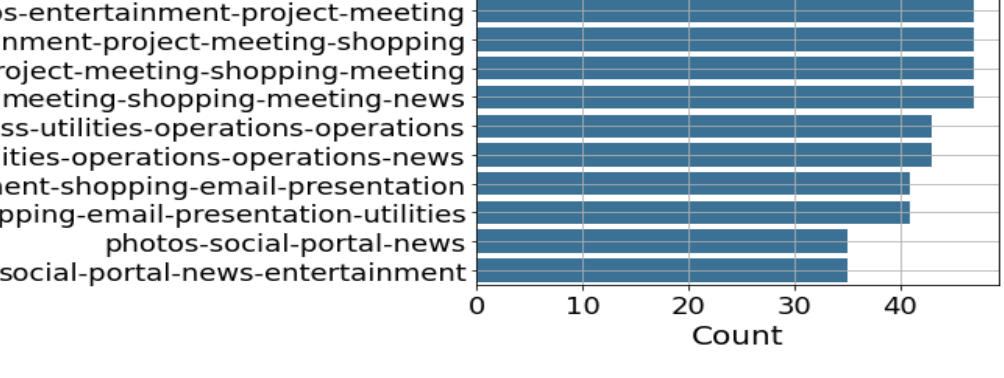
Figure 14. Top N-gram for P3.